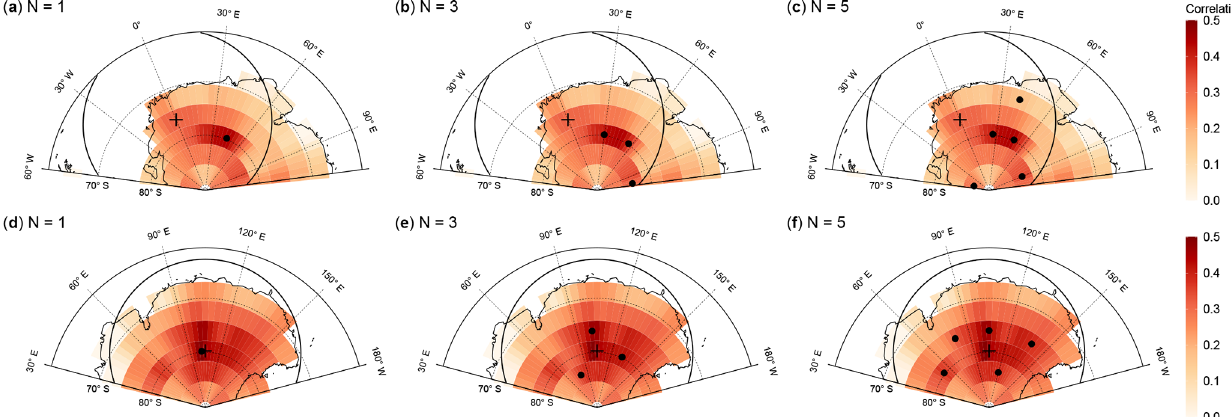
Figure 4. Selecting ice-core locations that optimally reconstruct interannual temperatures at the EDML and Vostok drilling sites. The maps show the correlation coefficient in the climate model data between the annual temperature time series at the target sites (black crosses) EDML ( a – c ) and Vostok ( b – f ) with the time series fields of precipitation-weighted oxygen isotope composition ( δ 18 O (pw) ). Filled black points denote grid cells that yield the maximum correlation between the target site temperature and the δ 18 O (pw) time series from either selecting a single grid cell ( N (cid:96) = 1; a , d ) or from averaging across N (cid:96) = 3 ( b , e ) or N (cid:96) = 5 ( c , f ) grid cells, obtained from iteratively selecting sets of N (cid:96) grid cells from within a selection circle of 2000km radius around the target site indicated by the black radial lines (see Sect. 2.3.2 for details). Interestingly, non-local ice-core locations systematically show the strongest relationship with the target site